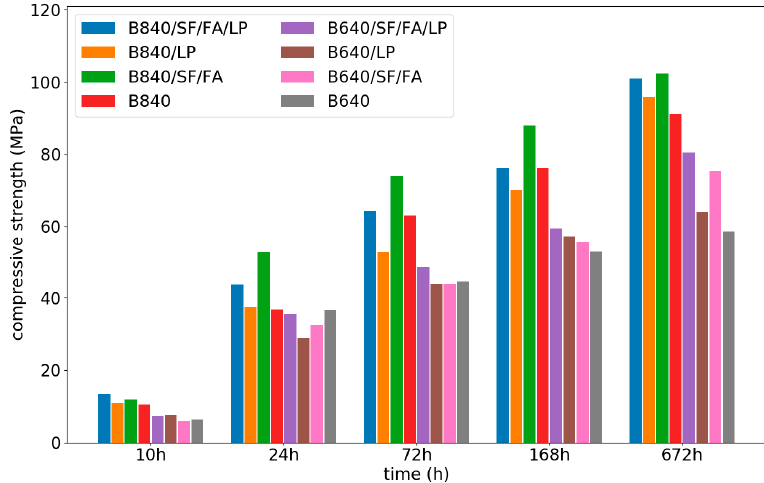
Figure 6. Compressive strength results.